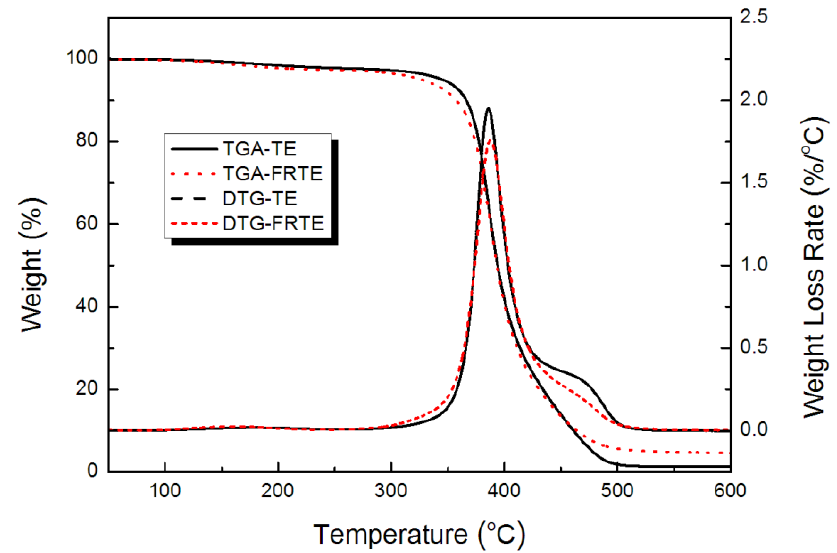
( b ) Figure 3. Residual char images of TE ( a ) and FRTE ( b ) after CONE measurement. 3.2. Thermal Stability The TGA/DTG curves for the degradation of the TE composites, at a heating ramp rate of 10 °C/min in nitrogen, are presented in Figure 4, and the data are listed in Table 2.